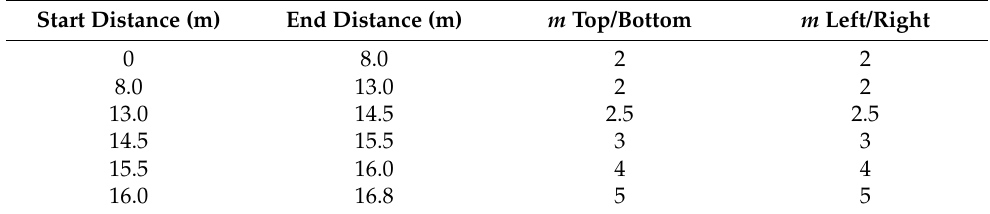
Table 1. Coating for the focusing system (both 3 × 3 cm 2 sample size, option 1, and 1 × 1 cm 2 sample size), distance is measured from the end of the long straight section.